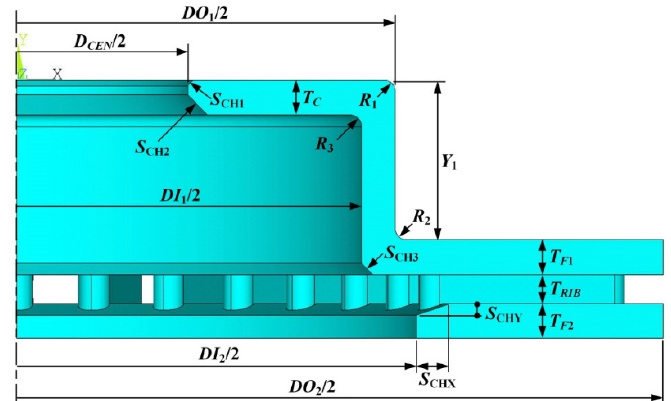
Figure 5. Geometrical parameters of the vented brake rotor.